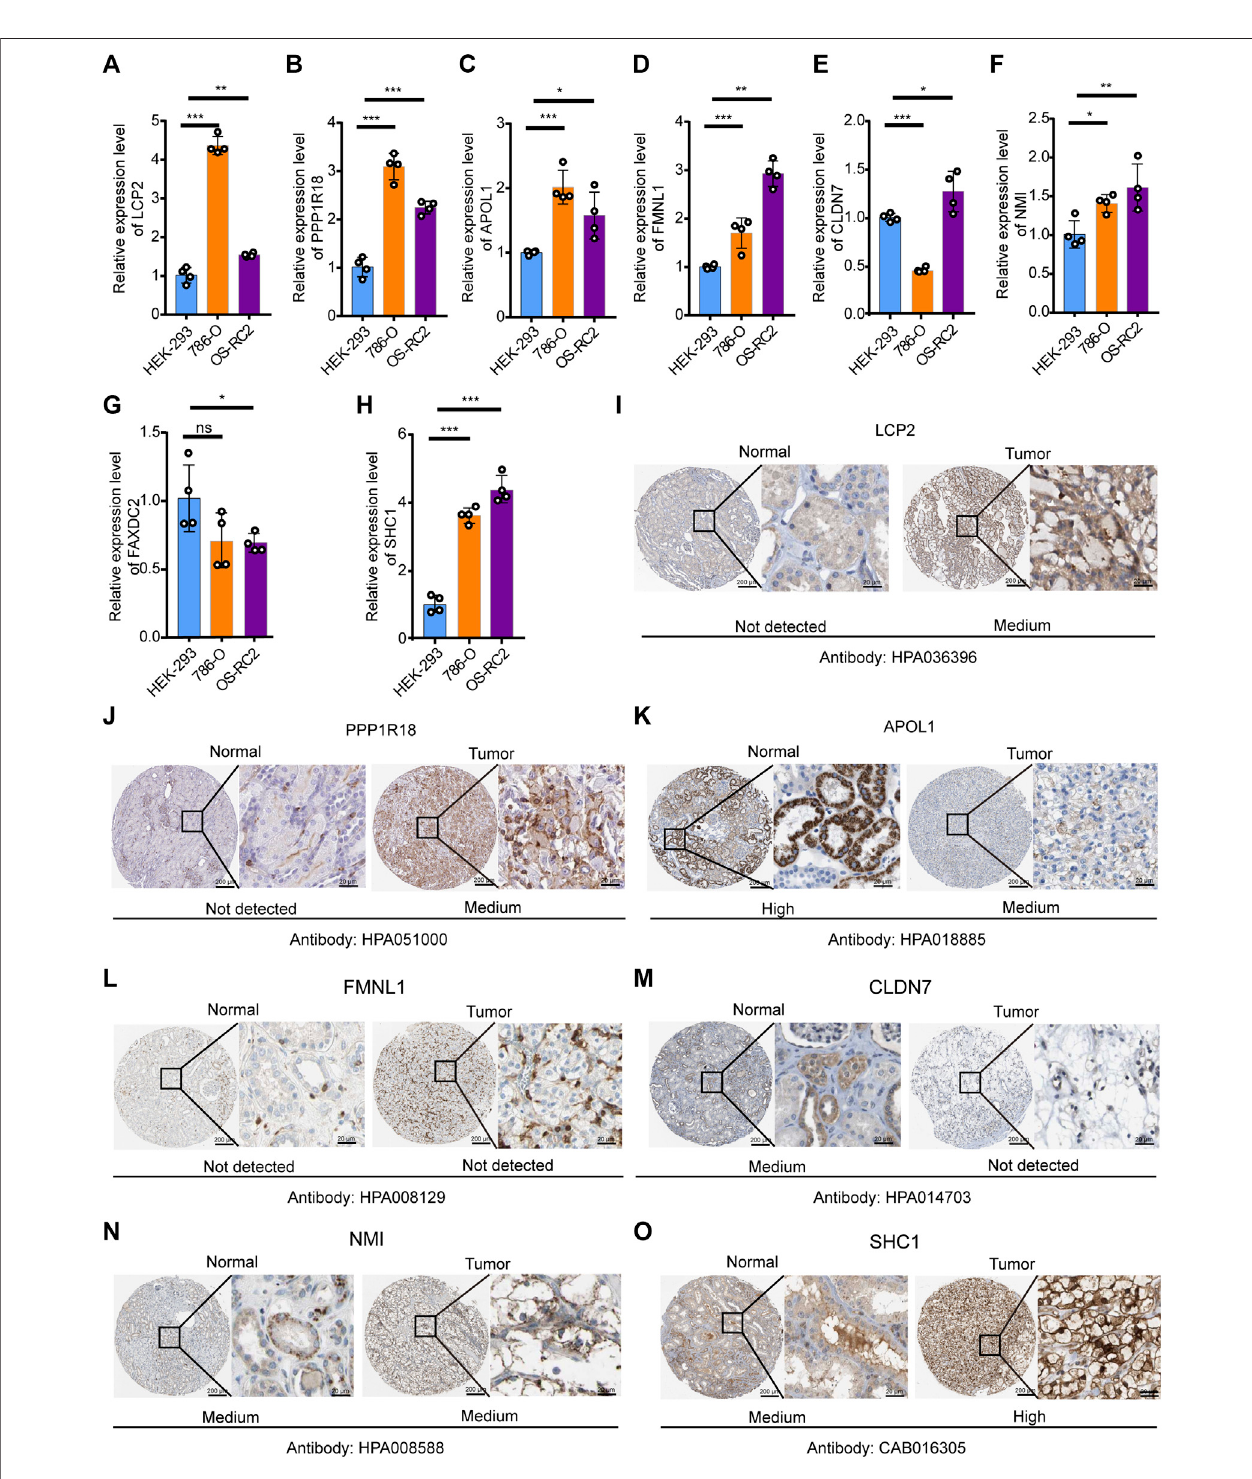
FIGURE 6 | Veri fi cation of expression levels of eight DEMDGs in vitro . Veri fi cation of expression levels of eight DEMDGs in vitro (A – H) Expression levels of eight DEMDGs in HEK-293 cells and RCC cells. (I – O) The representative protein expression of the eight DEMDGs in normal kidney tissue and RCC. Data were from the Human Protein Atlas database. FAXDC2 was not found in the database. * p < 0.05, ** p < 0.01, *** p < 0.001. ns, no sense.